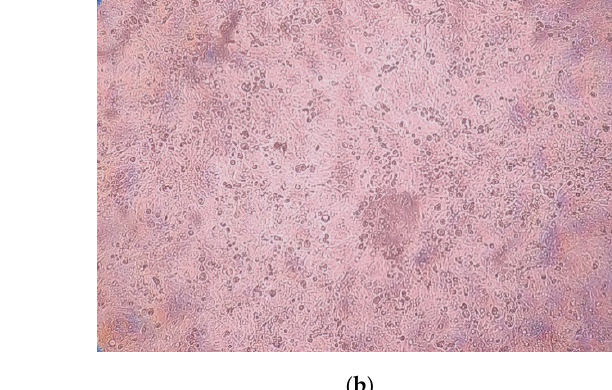
Table 1. Antiviral activity of hypertonic saline, coated on surgical